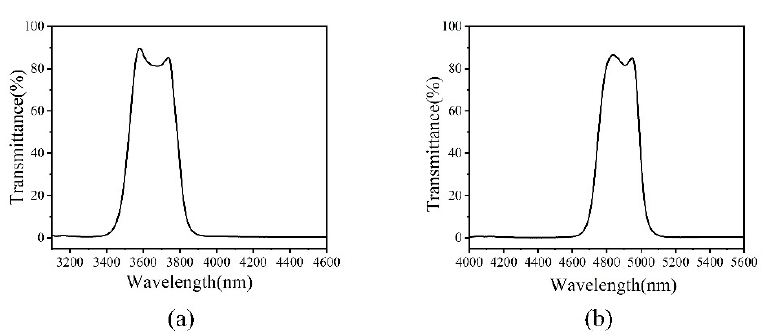
Figure 12. Measured transmittance of ( a ) bandpass filter for the region 3.55–3.75 µm and ( b ) band- pass filter for the region 4.85–4.95 µm. Zinc sulfide (ZnS) and germanium (Ge) were the thin-film materials used.